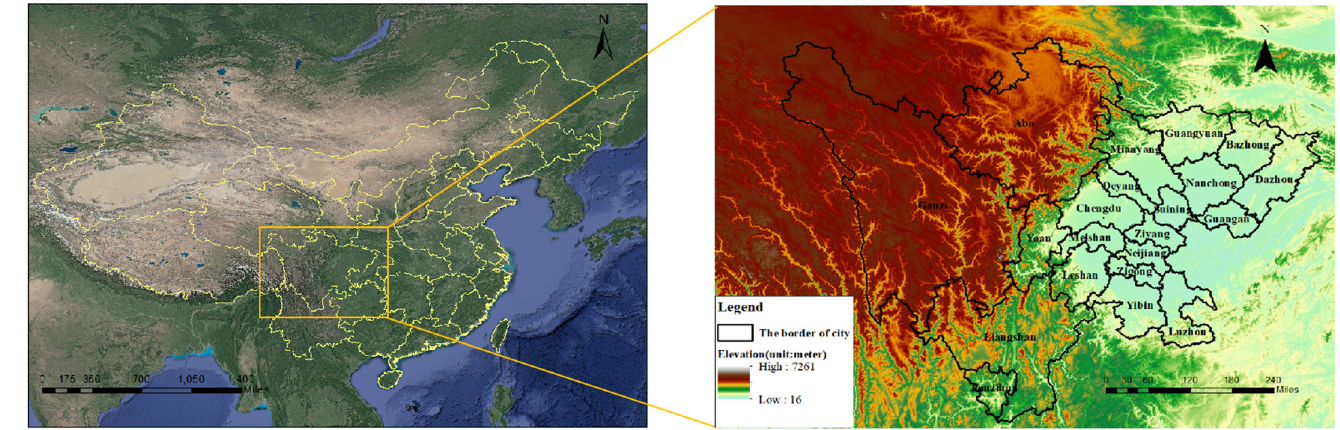
Figure 1. Geographical map and administrative division of Sichuan province.